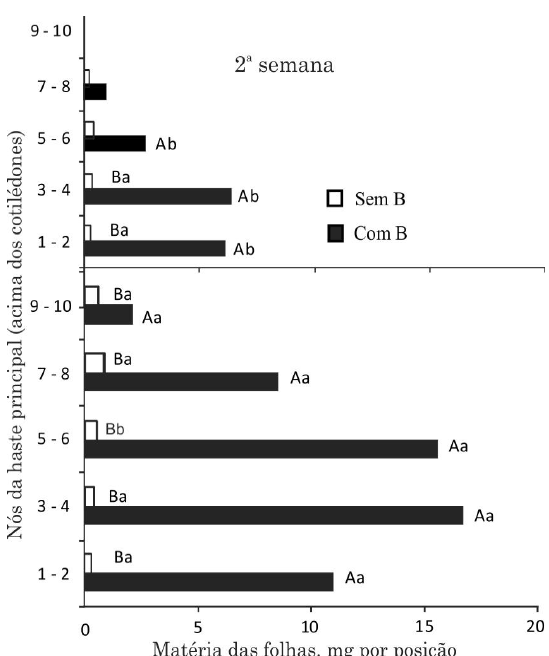
Figura 5. Matéria seca de folhas de diferentes nós da haste principal, na segunda e quarta semanas de avaliação, em cultivares de algodoeiro com e sem boro (média de quatro cultivares). Letras maiúsculas distintas indicam diferença significativa entre doses na mesma semana, e minúsculas indicam diferença significativa entre semanas, na mesma dose